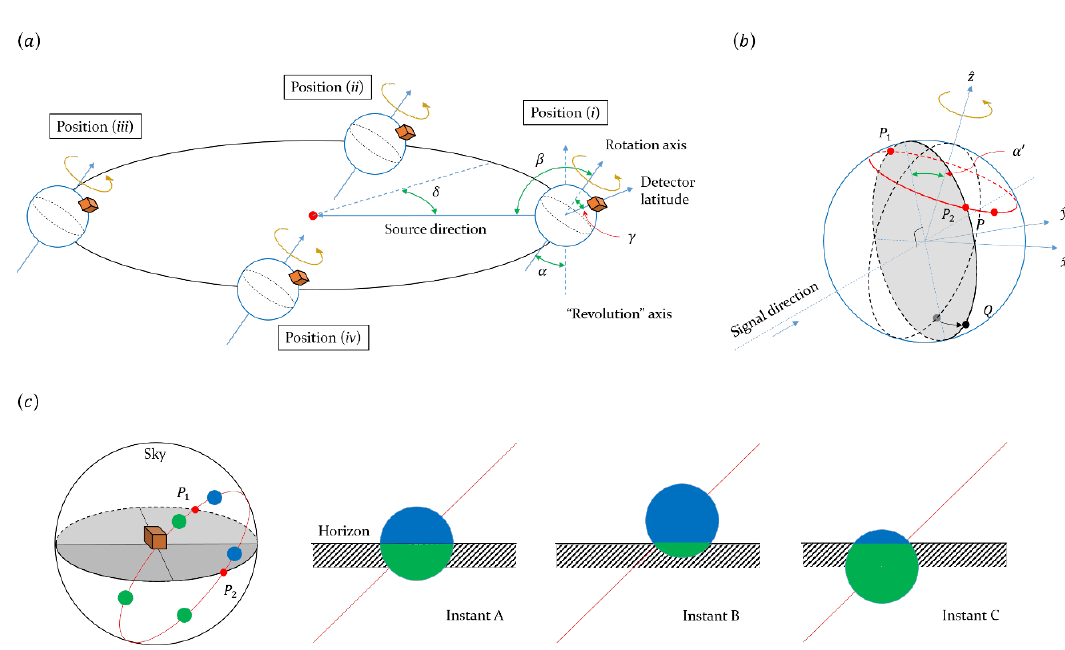
Figure 2 . Panel ( a ): various positions of the Earth relative to a given signal source point. Panel ( b ): some important coordinates related to the \Earth Shielding" method. The given detector here can use data from P 2 through P 1 . Panel ( c ): the travel of a non-point-like, (cid:18) C -cone-spanned